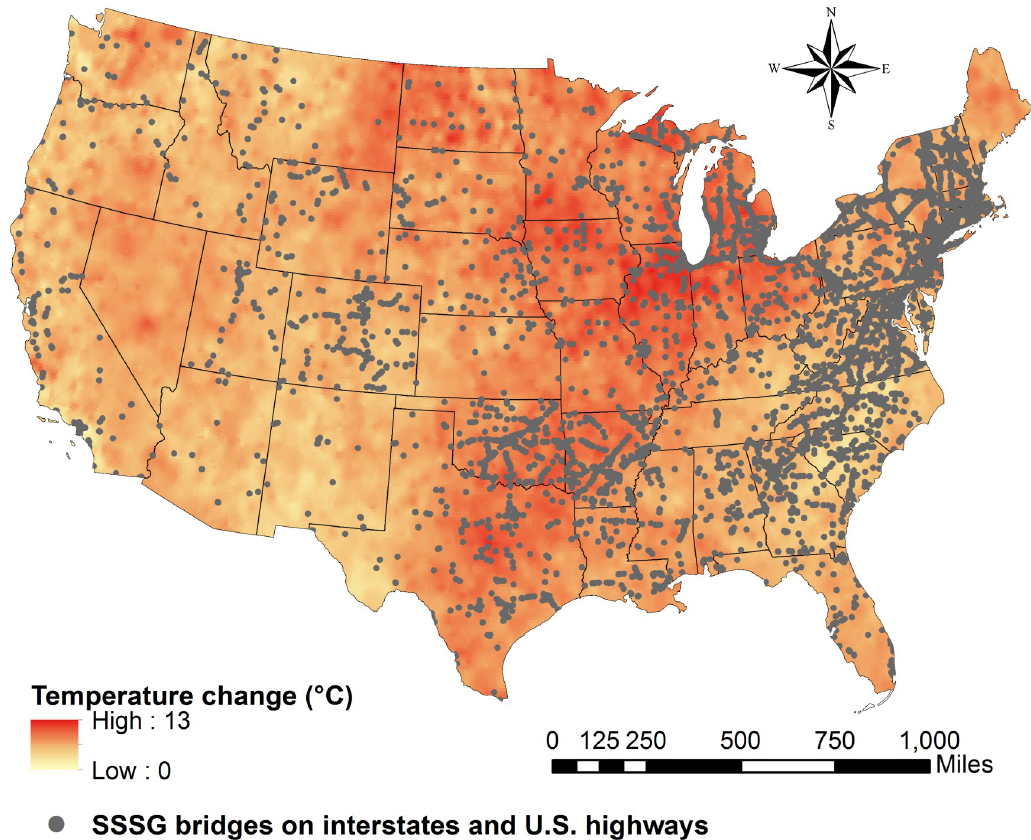
Fig 4. SSSG bridges on Interstate and US highways and projected daily maximum temperature change from 2020 to 2100 under the higher forcing scenario RCP 8.5.